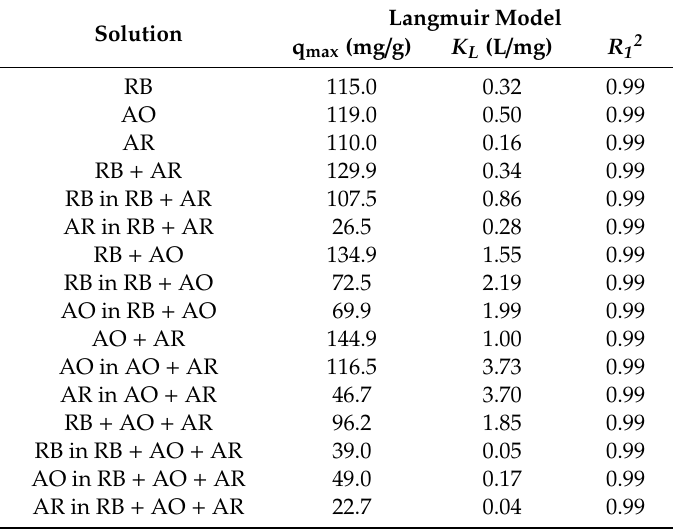
Table 2. Langmuir model fitting results of modified sepiolite adsorption.